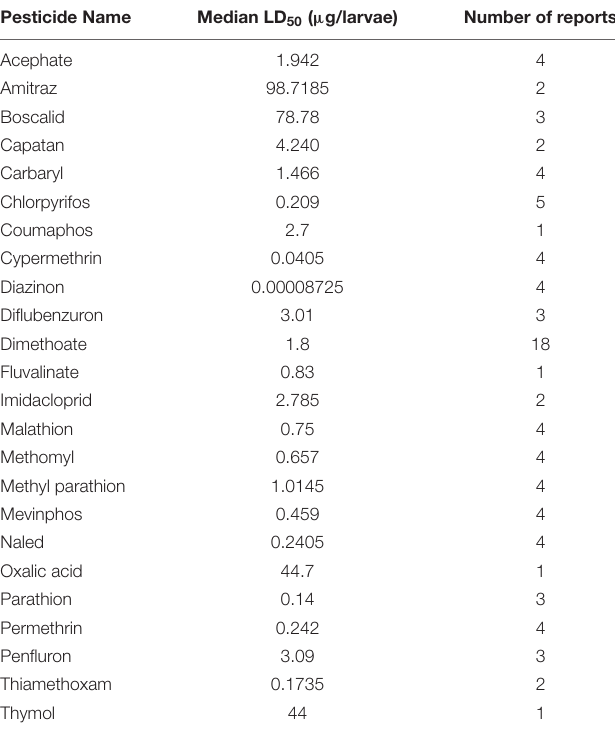
TABLE 3 | Median larval LD 50 values for various